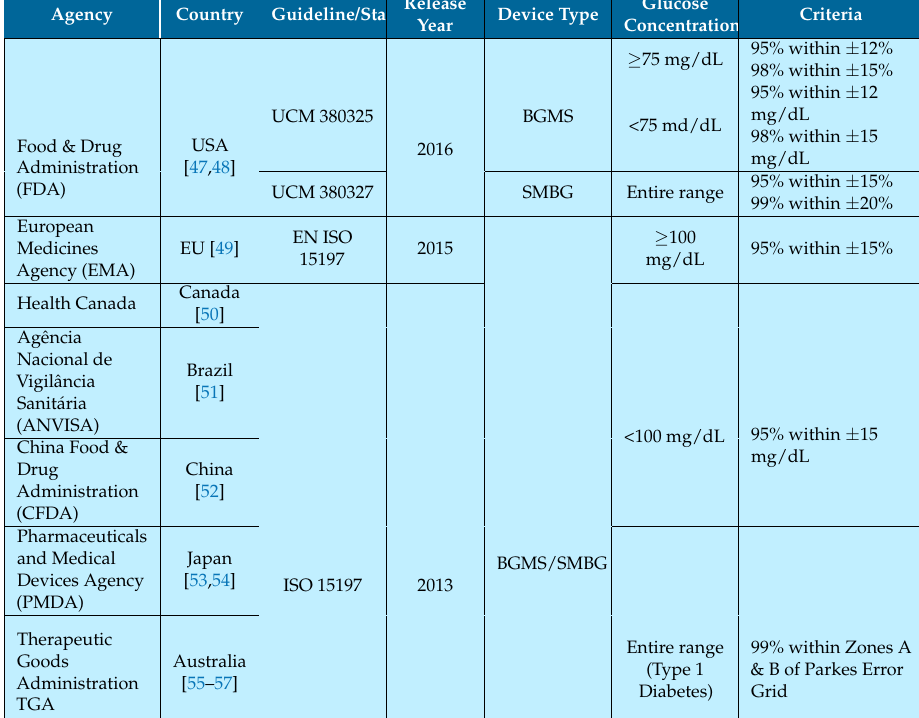
Table 4. Guidelines for approval of glucose monitoring devices in some